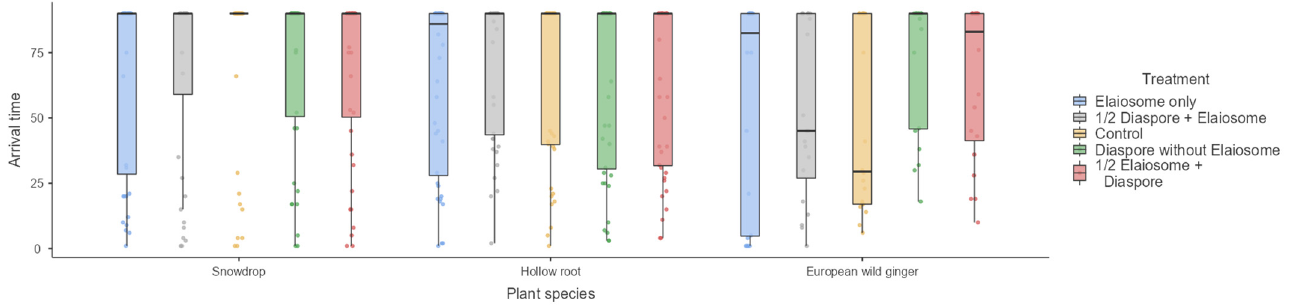
Figure 2. First ant arrival time (min) observed on diaspores/elaiosomes among three plant species. Box plots represent medians, 25th and 75th percentiles, minimum and maximum values.